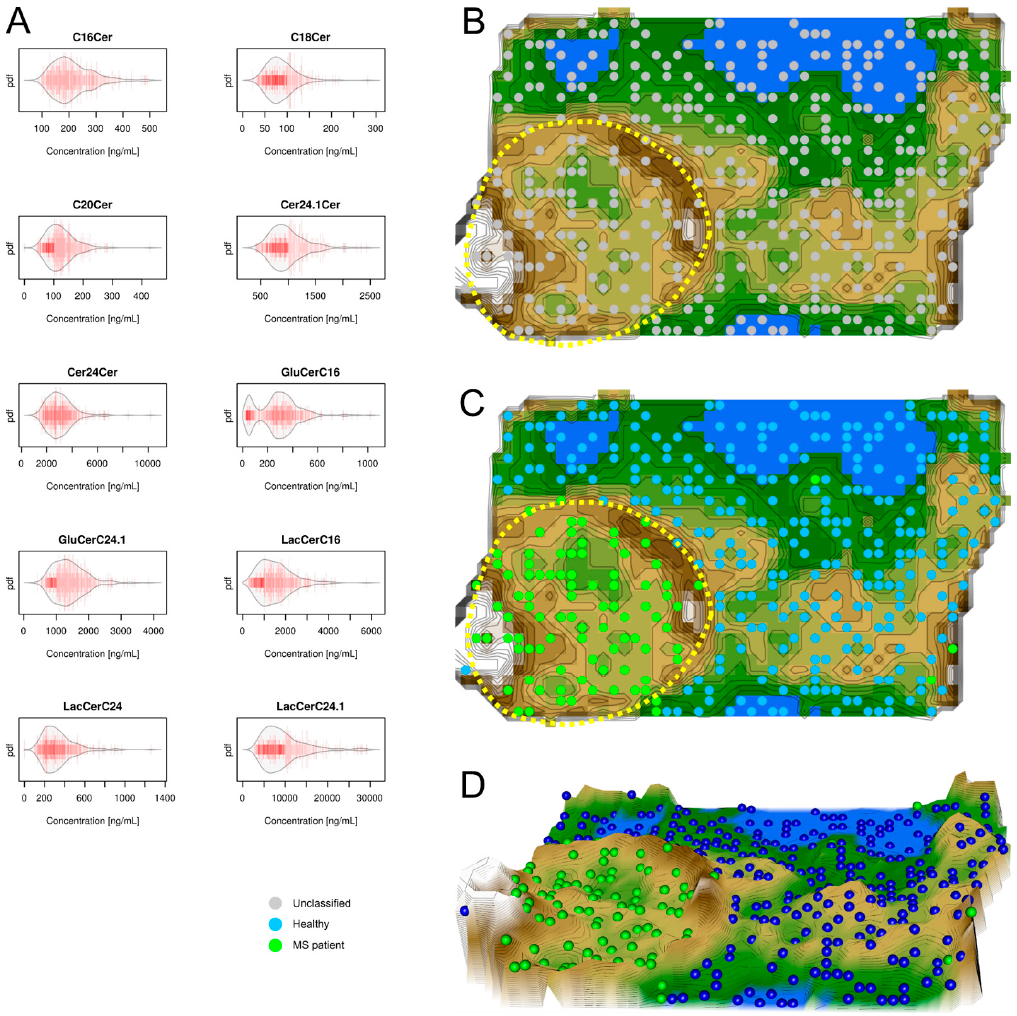
Figure 3. Data structures of ceramide serum concentrations: Left part, ( A ) Serum concentrations of d = 10 ceramides (raw data, complete cohort). The data are shown in alphabetical order of lipid mediator names. The beanplots [13] show the individual observations as small lines in a one-dimensional scatter plot, surrounded by a mirrored kernel density estimation of the distributions. Each panel displays a single ceramide marker and is composed of two one-sided beanplots of which the upper beanplot (green) shows the raw data acquired in multiple sclerosis patients and the lower beanplot (blue) shows the data acquired in the healthy subjects. Cer = ceramide, GluCer = glucosylceramide, LacCer = lactosylceramide. Right part, U*-matrix visualization of the distance and density based structures of the ceramide serum concentrations ( d = 10 ceramide markers) observed in n = 102 multiple sclerosis patients and n = 301 healthy subjects. The figure has been obtained using a projection of the data points onto a toroid grid of 1,440 neurons where the opposite edges are connected. The U*-matrix was colored as a geographical map with brown heights and green valleys with blue lakes. Valleys indicate clusters and watersheds indicate borderlines between different clusters. The dots indicate the so-called “best matching units” (BMUs) of the self-organizing map (SOM), which are those neurons whose weight vector is most similar to the input. A single neuron can be the BMU for more than one data point or subject, hence, the number of BMUs may not be equal to the number of subjects as in the present case. Differently colored BMUs represent healthy versus MS patient groups; ( B ) projection of the markers shown in A onto a self-organizing map. On the raw U-matrix, the BMUs are colored neutrally. A cluster structure emerges as two separate clusters. One cluster region at the lower left part of the U*matrix is marked with a dotted yellow line; ( C ) analysis of agreement between the data structure and grouping of the cohort. When the group membership to either the MS patients (green dots) or the healthy subjects (blue dots) is projected onto the U*-matrix, it becomes clear that the separate cluster surrounded by the yellow dotted line contains only MS patients while the remaining cluster contains nearly only healthy subjects. This indicates an almost